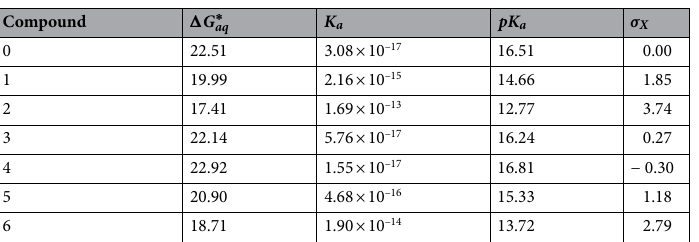
Table 8. Relative Gibbs free energy ( (cid:31) G ∗ aq , calculate by using the Eq. (10)) in kcal/mol, equilibrium constant ( K a , calculate by using the Eq. (14)), pK a (calculate by using the Eq. (10), and Hammet constant ( σ X , calculate by using the Eq.